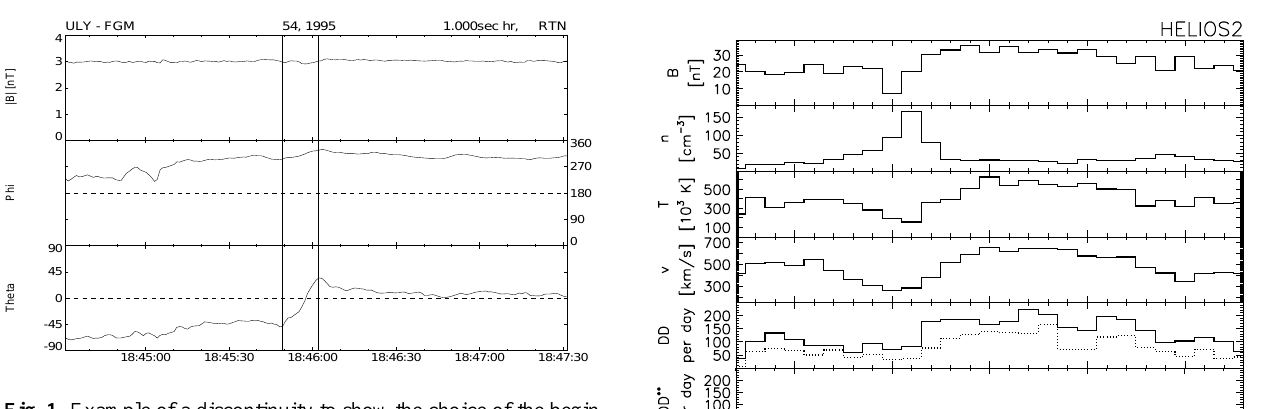
Fig. 1. Example of a discontinuity to show the choice of the begin- ning and the end of the layer.